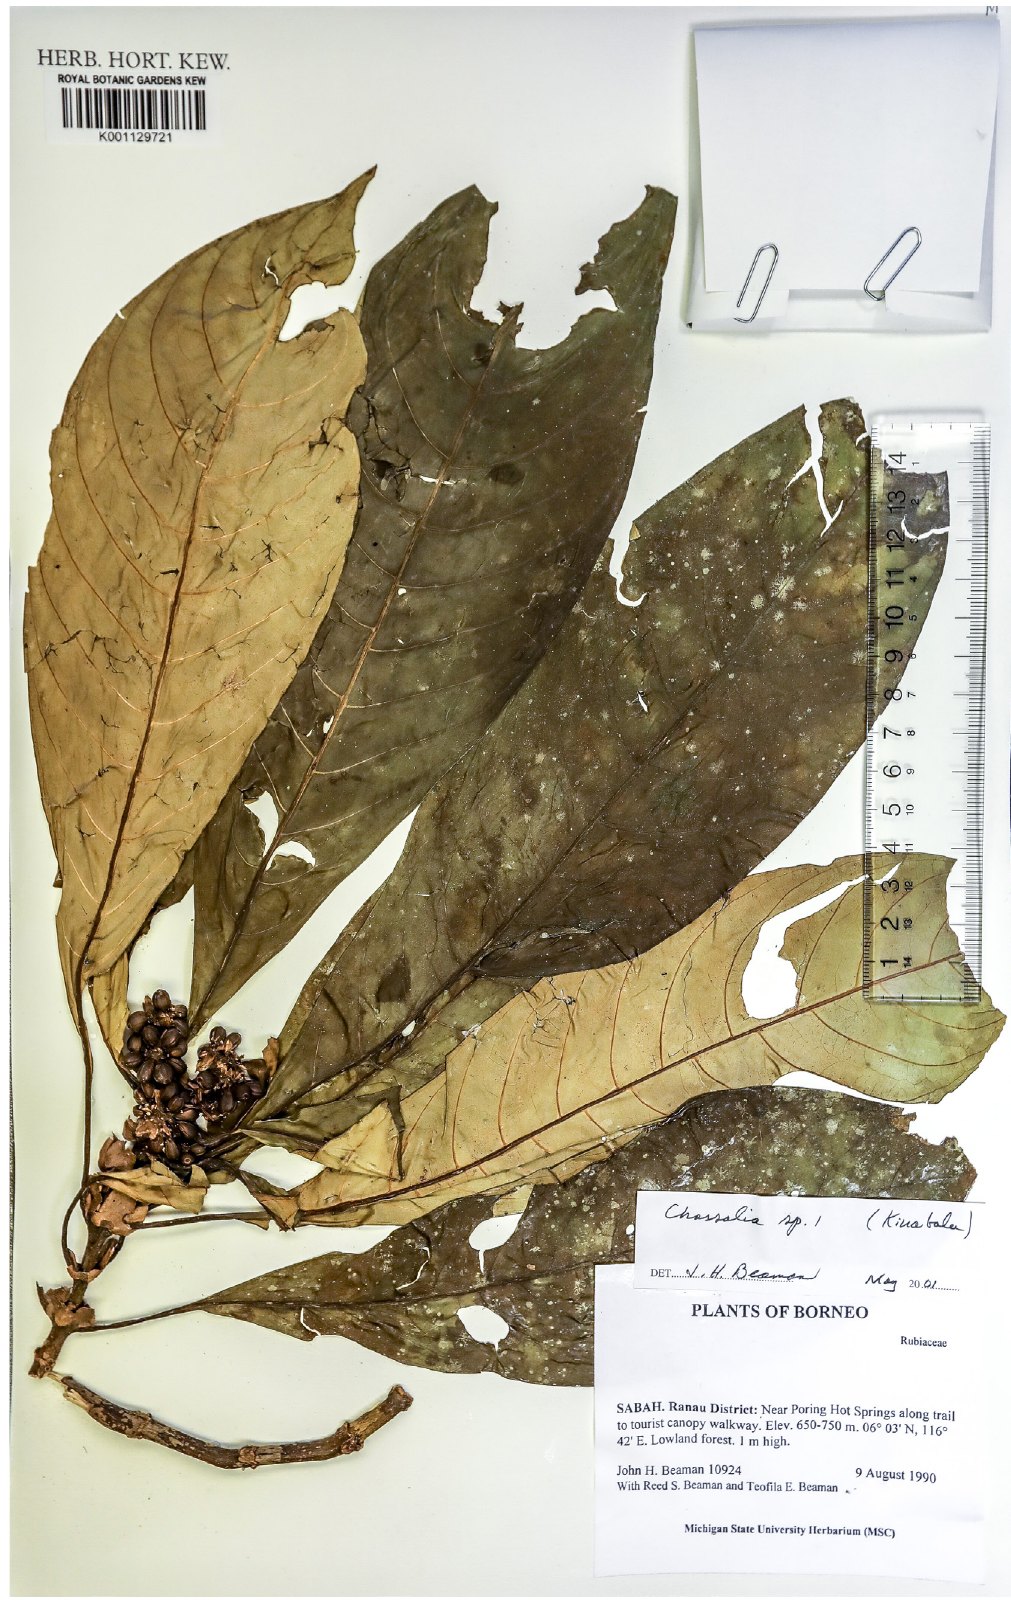
Fig. 7. Holotype of Chassalia beamanii T.Y.Yu sp. nov. ( John H. Beaman 10924